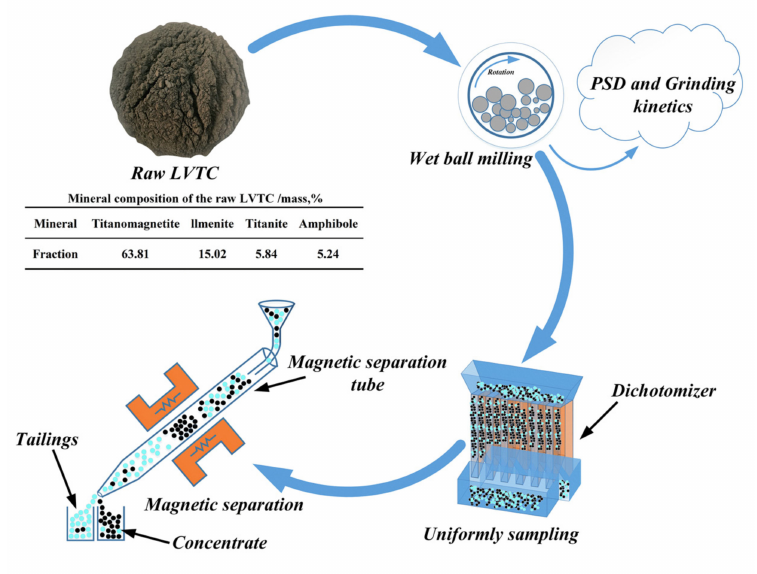
Figure 2. Flowchart of the grinding and magnetic separation